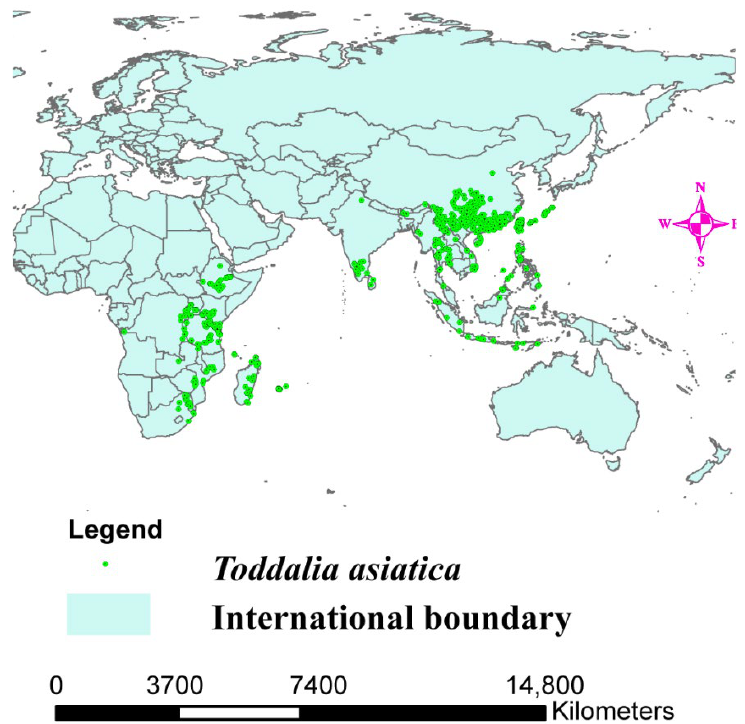
Figure 1. Distribution map of Toddalia asiatica in Africa and Asia.